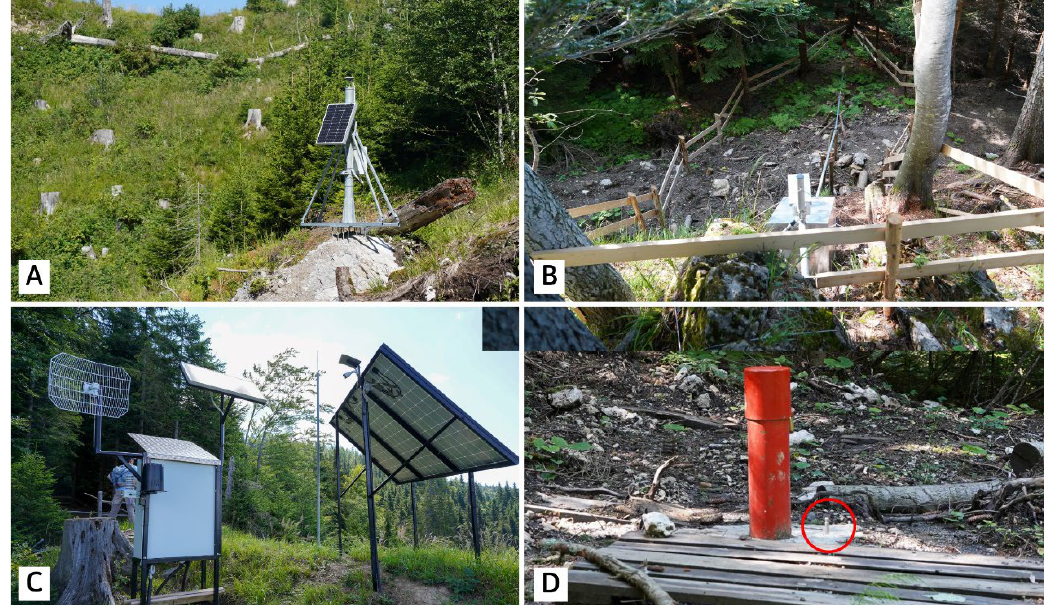
Figure 3. ( A ) : The GNSS 4 provides continuous monitoring of surface displacements at the toe of the landslide; ( B ): A wire extensometer continuously monitors the opening of the right flank; ( C ): The base station provides power for in situ geotechnical electronic devices and serves as in situ data storage; ( D ): Object points for tachymetric measurements are located next to the boreholes.